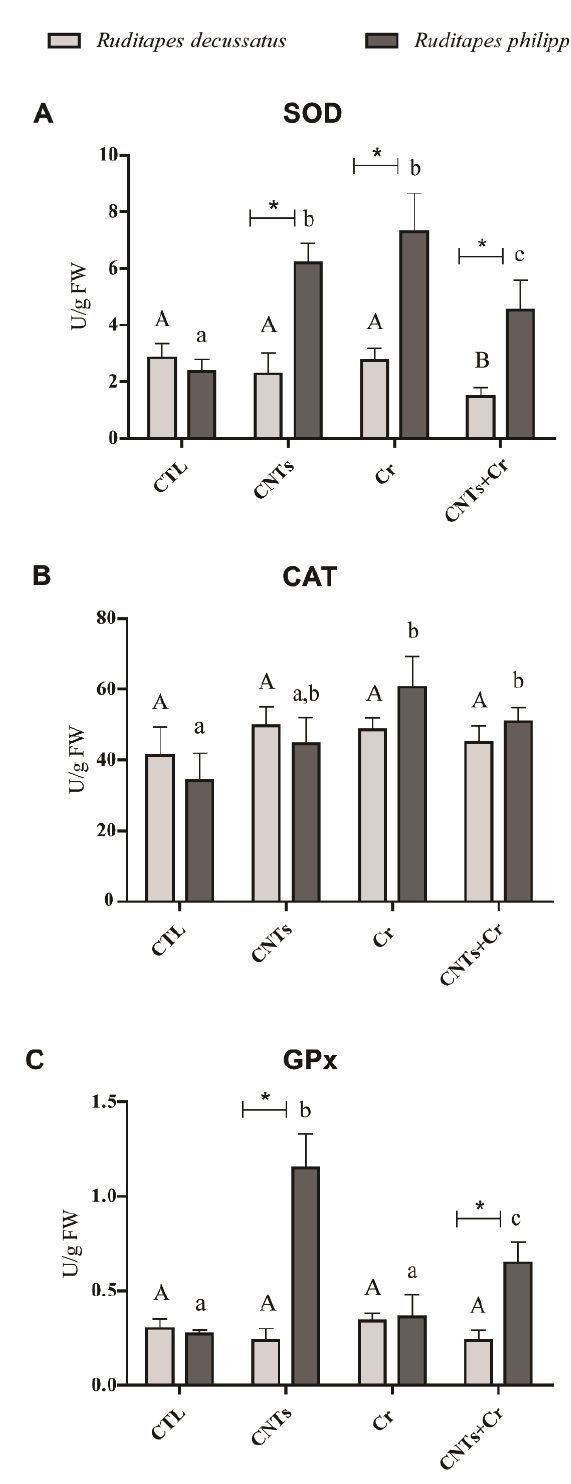
Figure 3. ( A ) Superoxide dismutase (SOD); ( B ) Catalase (CAT); (C) Glutathione peroxidase (GPx) activities (mean values+ standard deviation), in Ruditapes decussatus (light gray bars) and Ruditapes philippinarum (dark gray bars) after a 28-day exposure period. For each species, tested treatments were: control (CTL), carbon nanotubes (CNTs), chromium (Cr), and the combination of both contaminants (CNTs + Cr). Significant differences ( p < 0.05) among treatments are represented with different letters (lowercase for R. decussatus and uppercase for R. philippinarum ). For each treatment, significant differences ( p < 0.05) between R. decussatus and R. philippinarum are represented with an asterisk